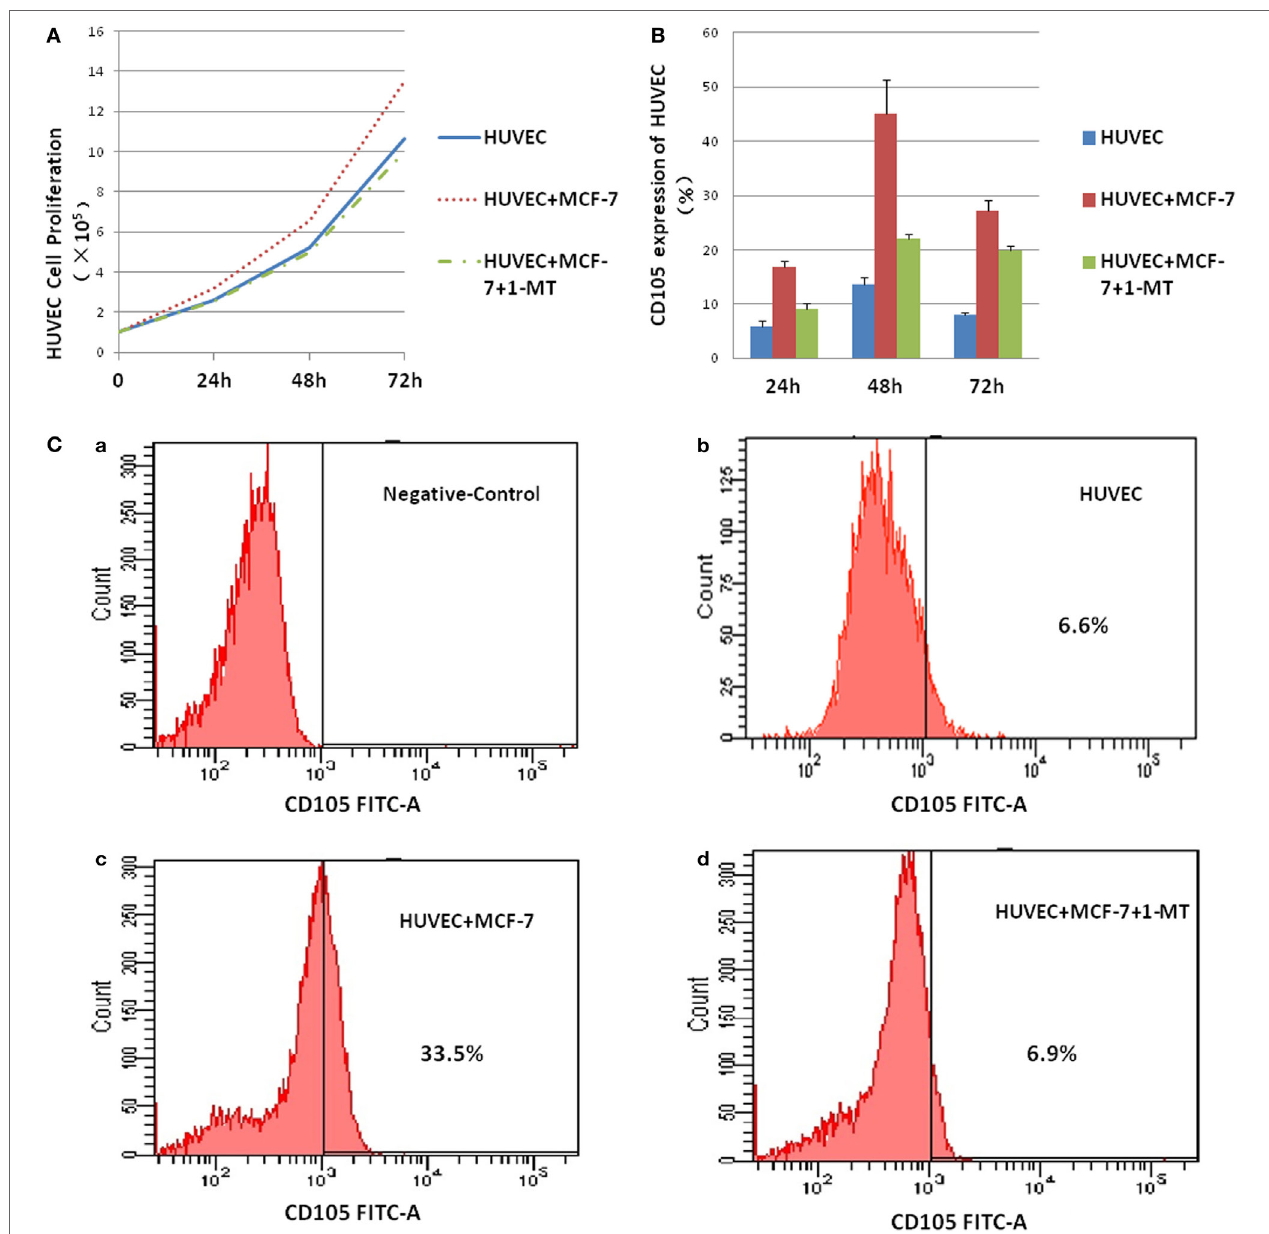
FigUre 6 | Indoleamine 2,3-dioxygenase (IDO) on human umbilical vein endothelial cells (HUVEC) activity. Co-culture of MCF-7 and HUVEC was performed in the presence or absence of the IDO inhibitor 1-methyl- d -trytophan (1-MT). (a) HUVEC proliferation was measured using the Cell Counting, IDO promoted HUVEC cell proliferation significantly compared with control after co-culture for 3 days. (B) CD105 expression by HUVEC in the control [ (c) (a)], HUVEC groups [ (c) (b)], HUVEC + MCF-7 groups [ (c) (c)], and HUVEC + MCF-7 + 1-MT groups [ (c) (d)] were detected by flow cytometry. CD105, which was upregulated expression in HUVEC + MCF-7 group compared with control group, was downregulate expressed after adding inhibitor 1-methyl- d